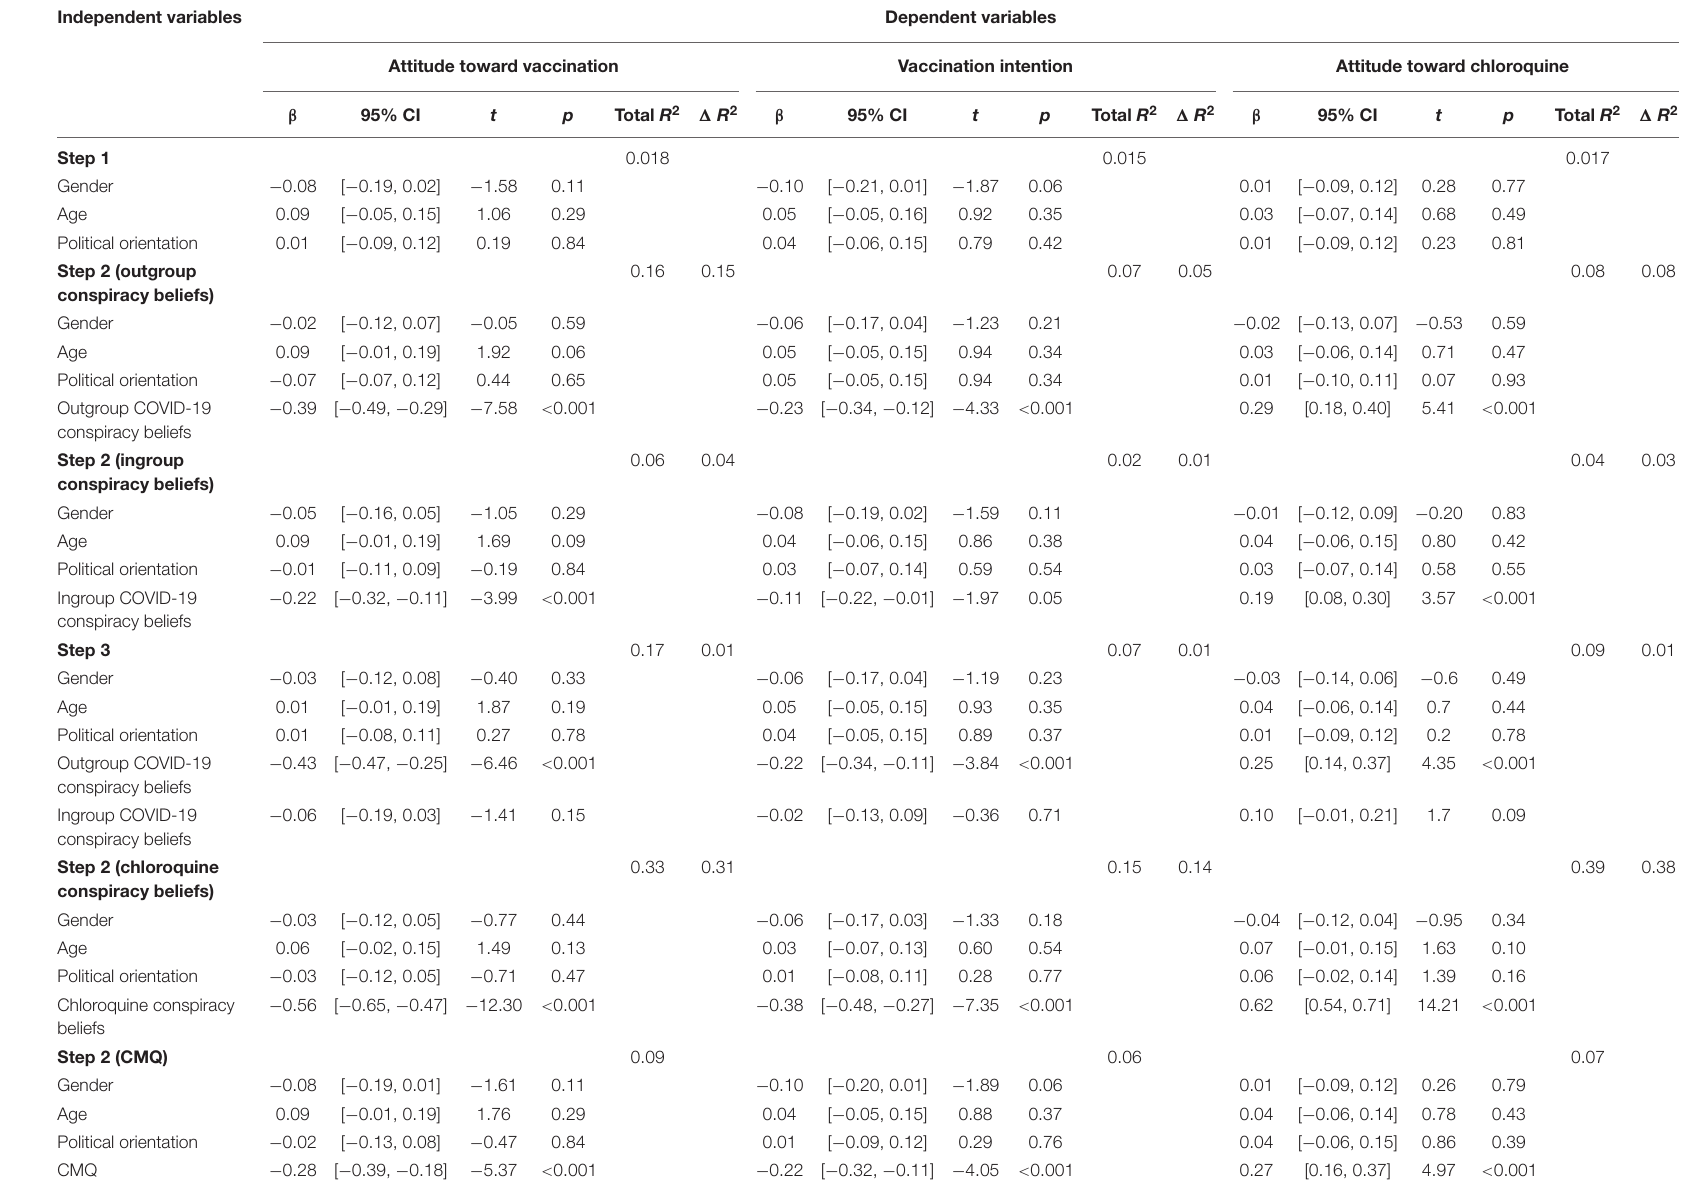
TABLE 4 | Hierarchical regressions on attitude toward vaccination, vaccination intention, and attitude toward chloroquine controlling for gender, age, political orientation (study